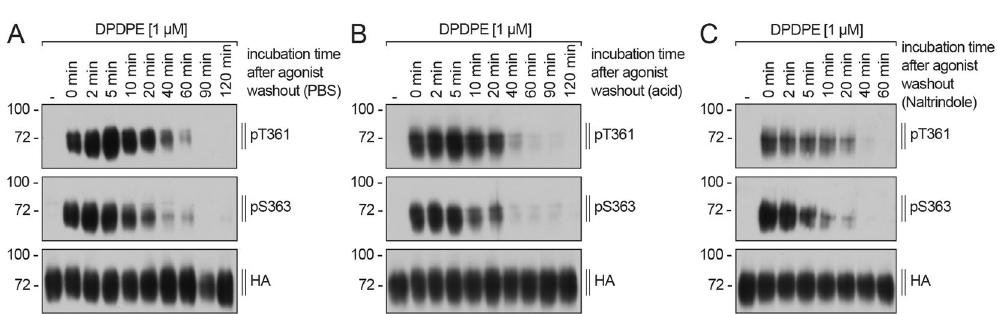
Figure 8. Time-course of DOP receptor dephosphorylation. ( A–C ) Stably HA-hDOP receptor expressing HEK293 cells were treated with 1 µ M DPDPE for 10 min at 37 °C, three times washed with( A ) PBS, ( B ) citrate buffer or ( C ) citrate buffer containing naltrindole and then incubated in the absence of DPDPE in serum-free medium for the indicated times at 37 °C. Lysates were immunoblotted with antibody to pT361 or pS363. Blots were stripped and reprobed with the anti-HA antibody. Blots are representative, n =